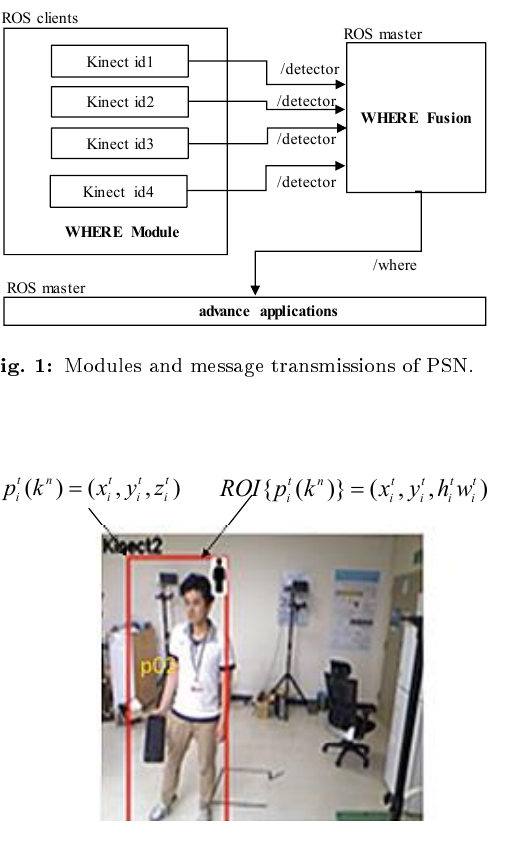
Fig. 2: Features of detected human in FOV of Kinect n : 3D location at top left corner and